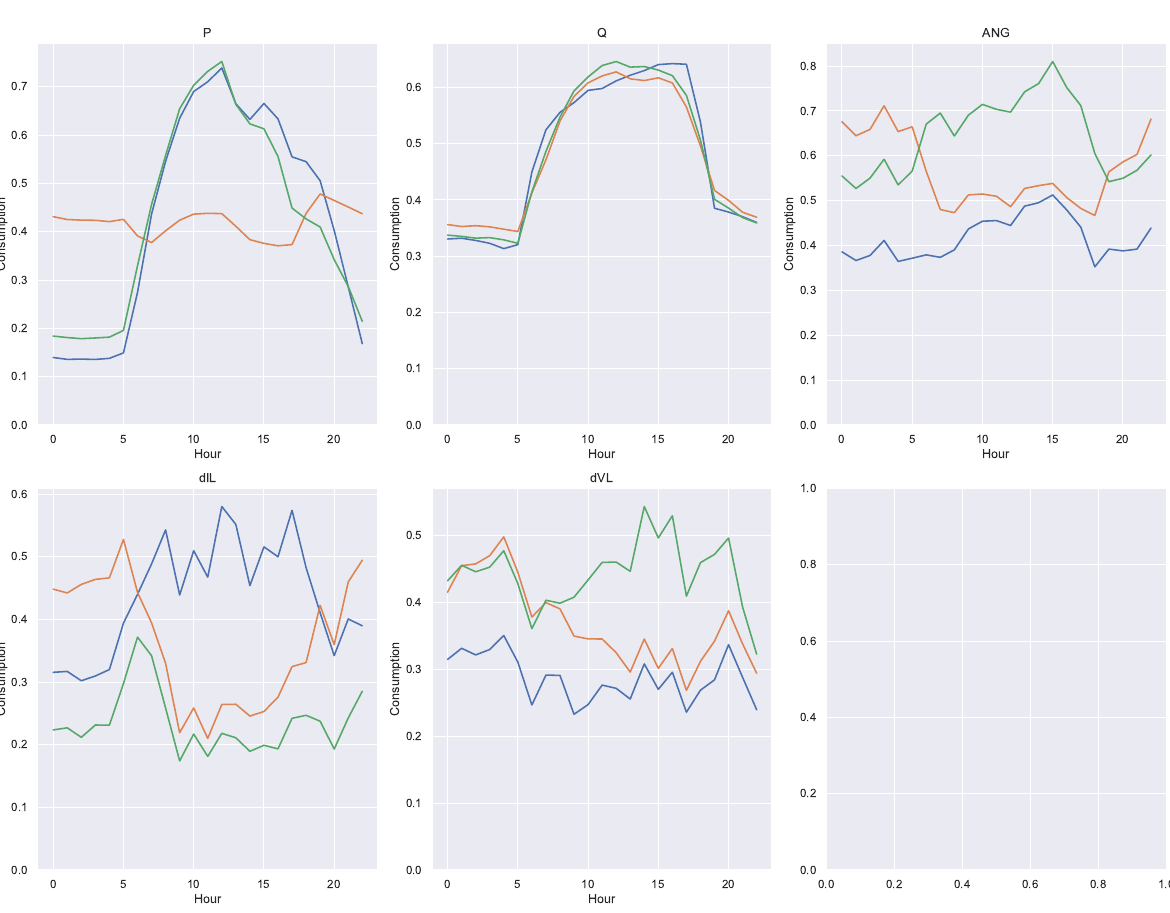
Figure 22. Prototype clusters obtained with the extended variables in Scenario B. Each color represents a single